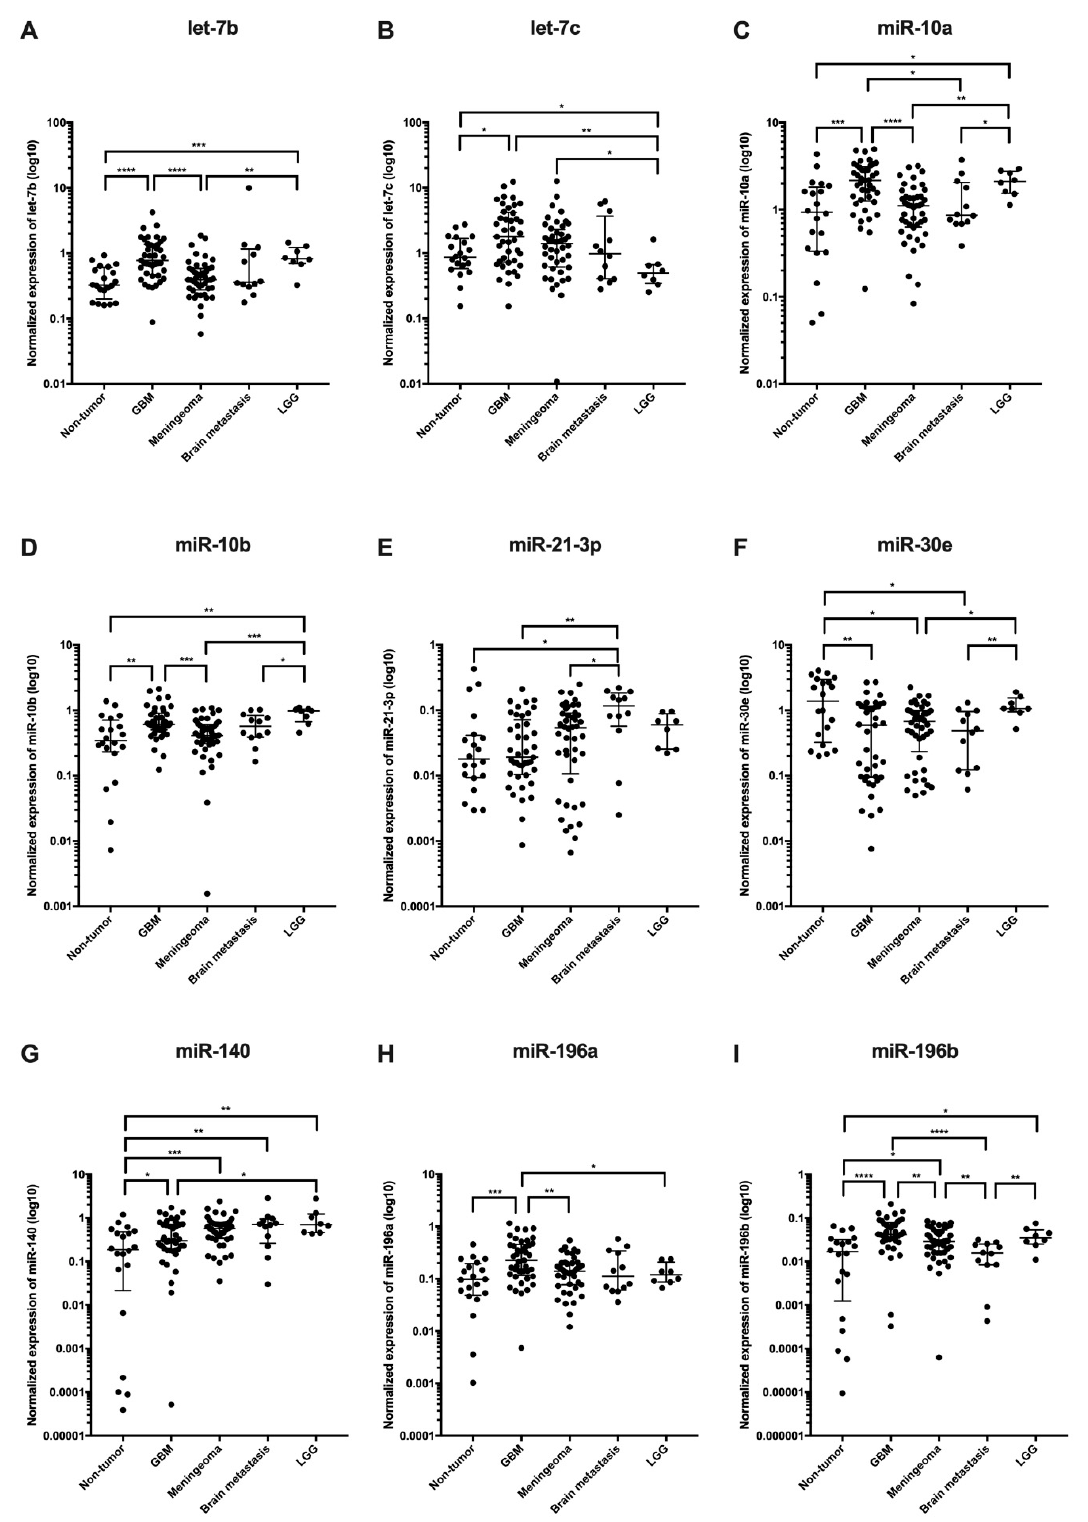
Figure 2. Validation of candidate cerebrospinal fluid miRNA biomarkers ( A let-7b, B let-7c, C miR-10a, D miR-10b, E miR-21-3p, F miR-30e, G miR-140, H miR-196a, I miR-196b). In controls, patients with glioblastoma (GBM), meningioma, brain metastasis, and low-grade glioma (LGG).